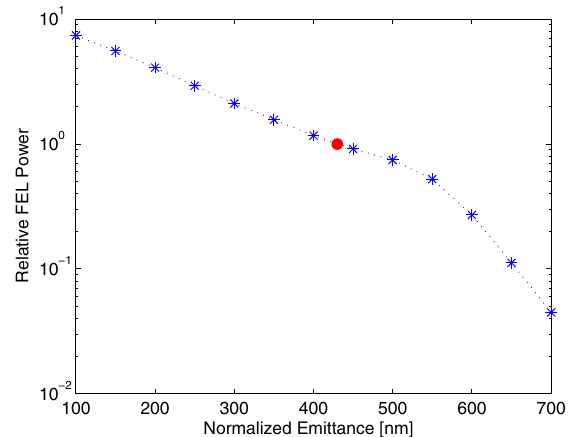
FIG. 1. Relative FEL power as a function of the normalized emittance. The reference case (100% relative FEL power) corresponding to the nominal emittance of 0 . 43 μ m is indicated by a red dot. The calculations are done with Genesis [3] after 12 undulator modules for the SwissFEL design parameters at 200